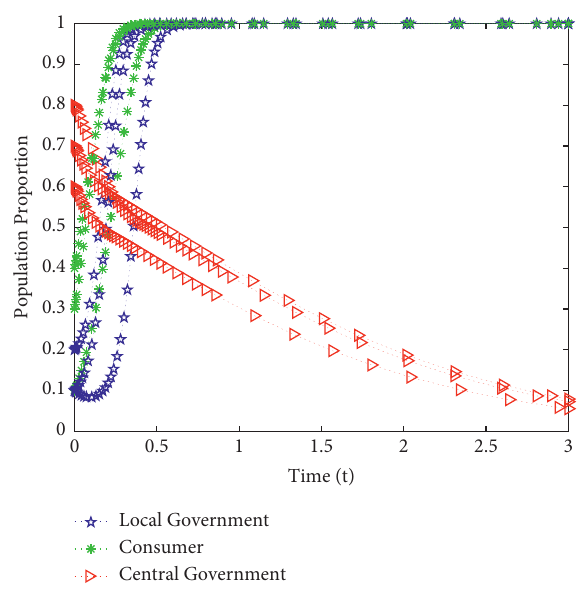
Figure 7: Evolution path of strategies chosen by three players with the stability point E 5